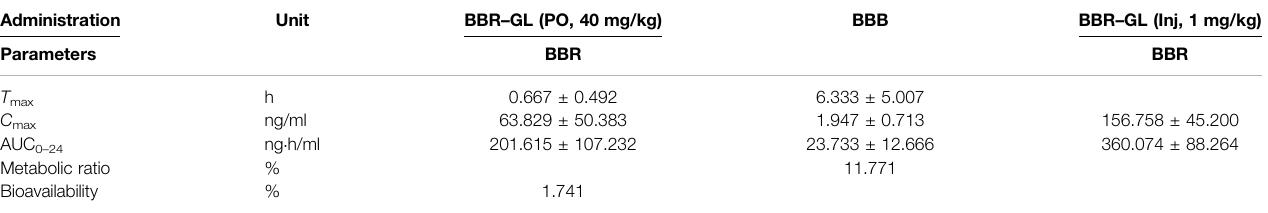
TABLE 3 | Pharmacokinetic parameters of BBR – GL and its metabolism following oral administration (containing 40 mg/kg BBR) and intravenous injection (containing 1 mg/kg BBR). Administration